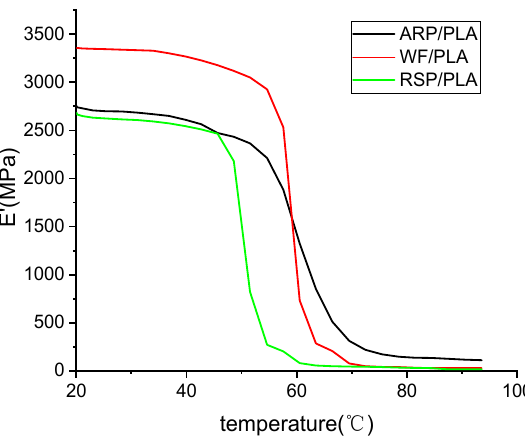
Figure 7. Storage modulus diagram of different samples (3.33 hz).